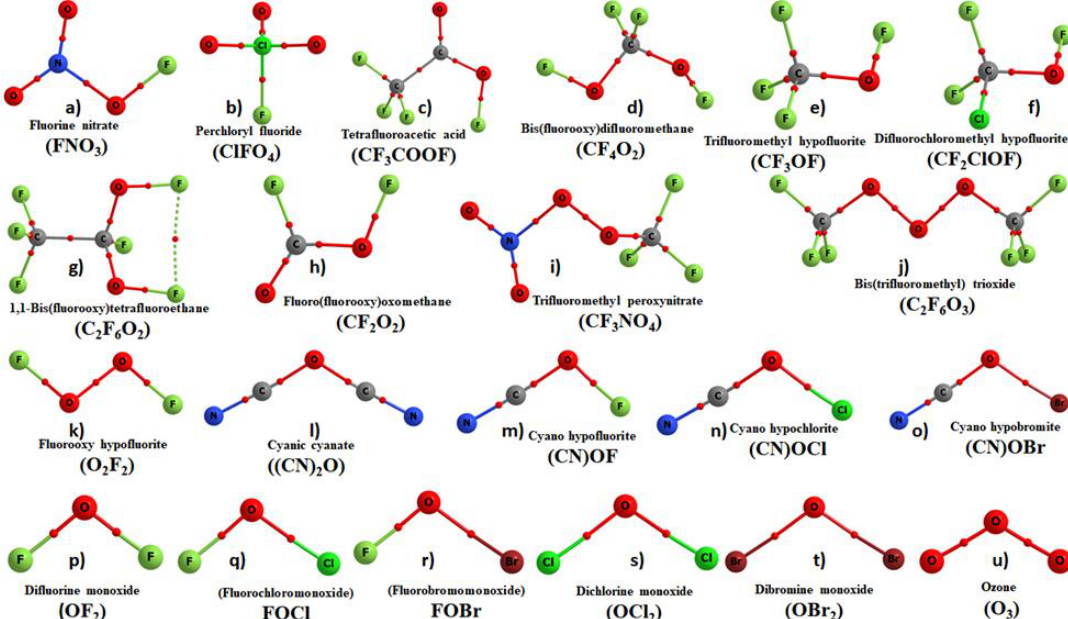
Figure 1. QTAIM molecular graphs of all the 21 monomer molecules examined, obtained on their corresponding MP2/aug-cc-pVTZ optimized geometries. Atom labeling is shown. The solid and dotted lines in atom color represent the bond paths, and the tiny red spheres between atomic basins represent the bond critical points.